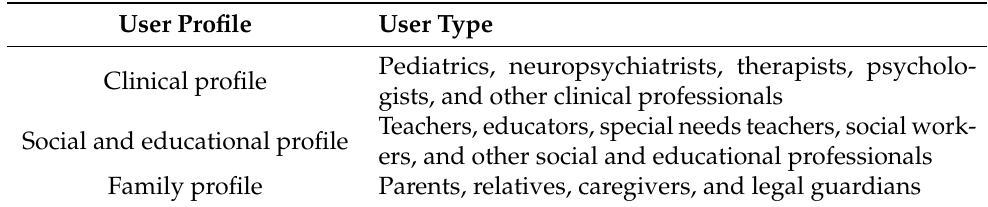
Table 1. Different user profiles created in the SUPER platform. The table reports the user profiles that could be created depending on the